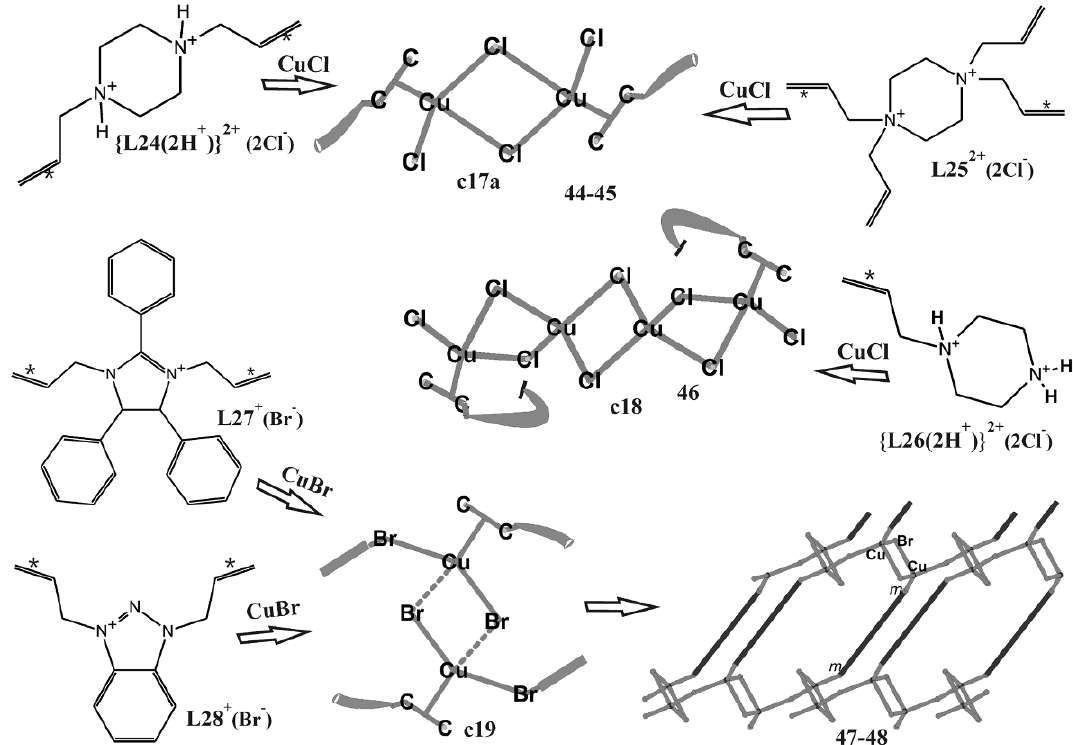
Figure 9. Structural genesis of C17-C19 fragments in 44-48